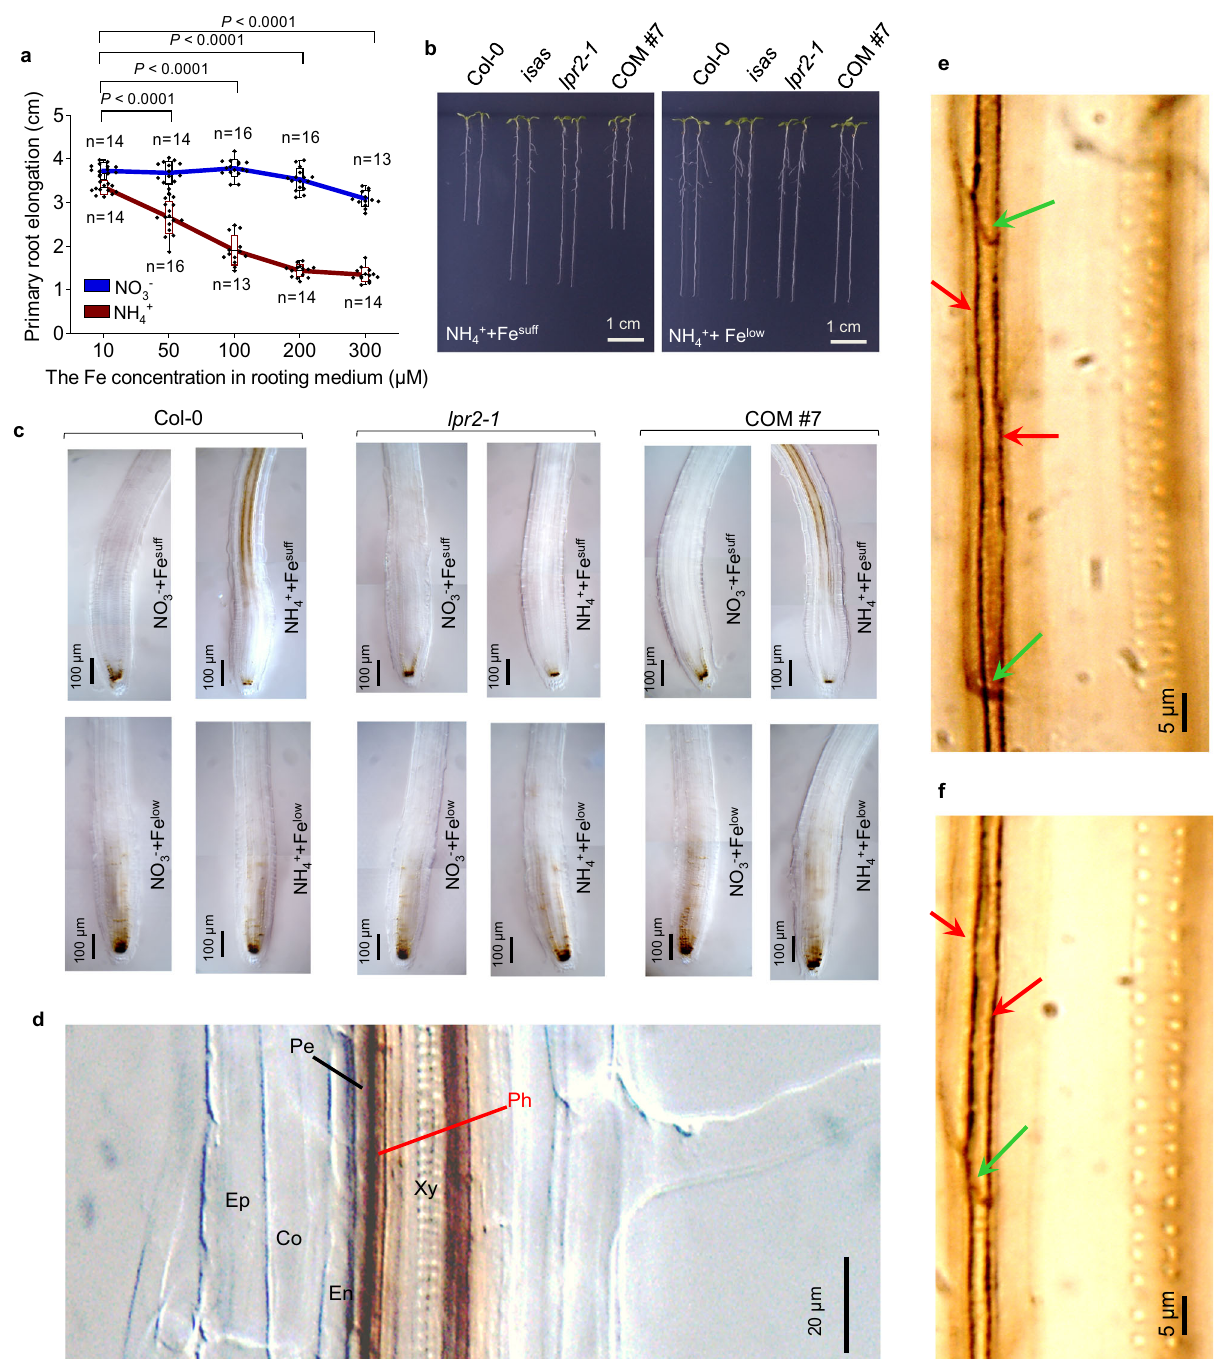
Fig. 3 Fe-dependent inhibition of primary root growth in NH4 + medium. a Primary root elongation of Col-0 seedlings in NO 3 − -N or NH 4 + -N source with various doses of Fe. Center line represents mean and bounds of box are SD; whiskers indicate the minimum and maximum values; n = number of seedlings. P values <0.05 indicate signi fi cant interactions between N form and Fe dose (two-way ANOVA with post-hoc Tukey HSD test). b NH 4 + -sensitivity comparison of Col-0, isas , lpr2-1 , and complementation line COM#7 in Fe suff (100 µ M) and Fe low (10 µ M) conditions. c Fe deposition indicated by Perls/ DAB staining in primary roots. d Close-up view of Fe deposition in root stele of Col-0 seedlings grown in Fe suff NH 4 + medium. Ep epidermis, Co cortex, En endodermis, Pe pericycle, Ph phloem, Xy xylem. e Perls/DAB staining in the phloem of the primary roots of Col-0 seedlings grown in Fe suff NH 4 + medium. Red and green arrows show Fe depositions at lateral cell walls and sieve plates of the phloem, respectively. f Acetone washed-Perls/DAB staining in phloem of the primary roots of Col-0 seedlings grown in Fe suff NH 4 + medium. The Perls/DAB-stained roots were washed with acetone for 3 h. Four-day- old seedlings of the indicated genotypes were transferred to NO 3 − or NH 4 + medium with various doses of Fe supply and analyzed 4 days after seedling transfer. Each experiment was repeated independently three times with similar results, and a representative experiment is